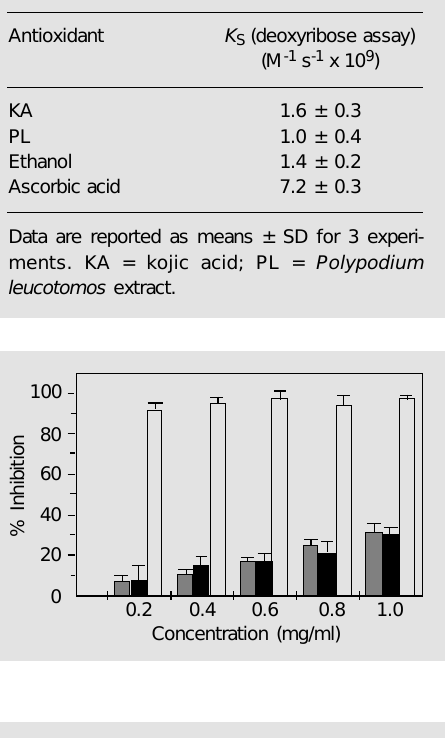
Figure 3. Inhibitory effect of Polypodium leucotomos extract (PL) and kojic acid (KA) (0.0 to 0.1 mg/ml) on H 2 O 2 . PL (gray bars), KA (black bars), and cata- lase (light gray bars) used as con- trol were detected by the scopo- letin